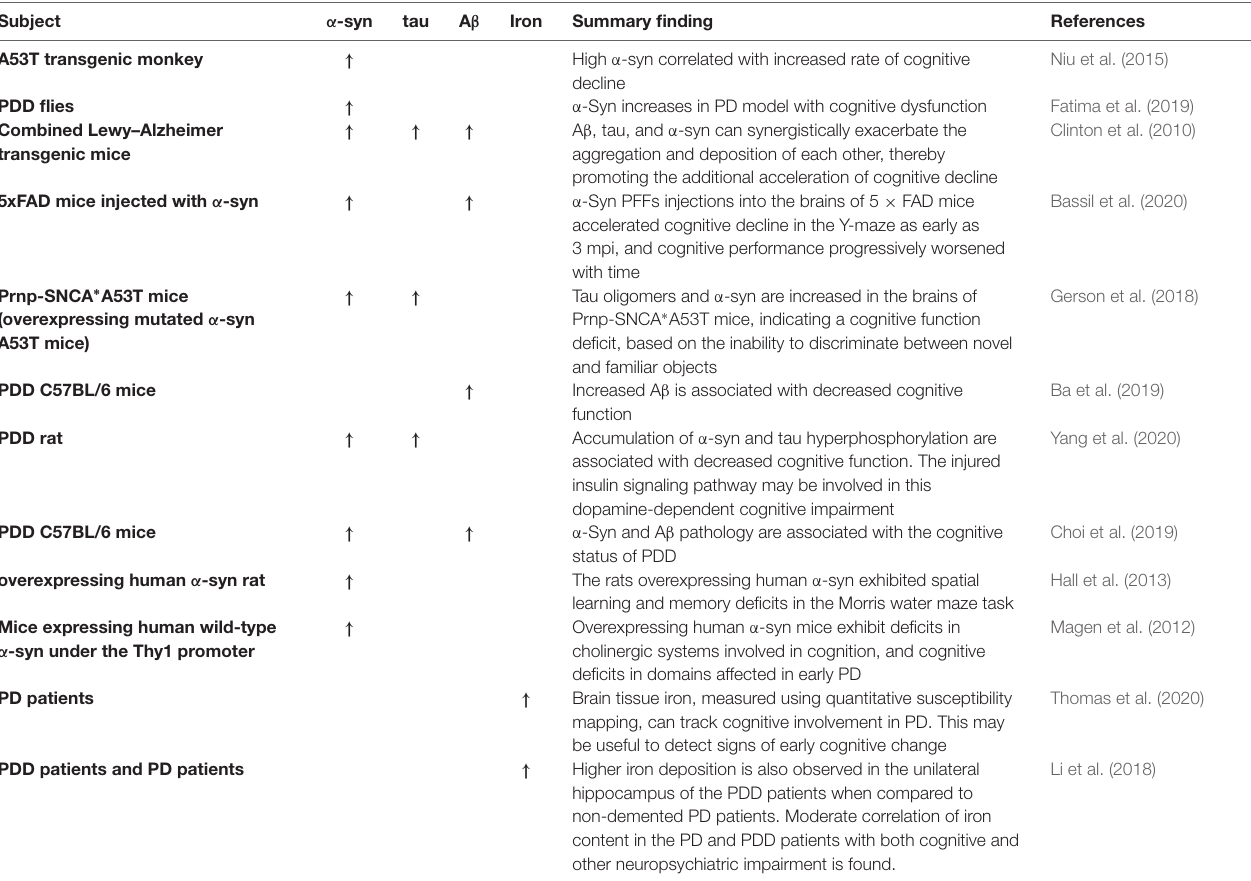
TABLE 1 | Changes of α -syn, tau, A β , and iron in